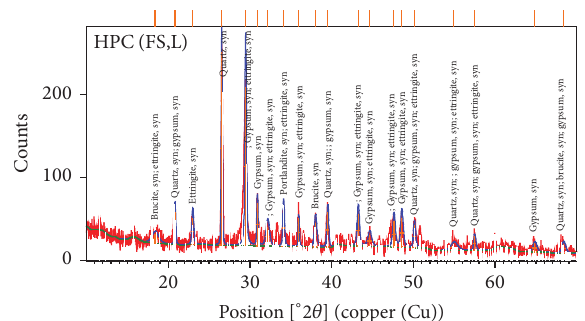
Figure 13: XRD patterns powder of concrete with binary sand.